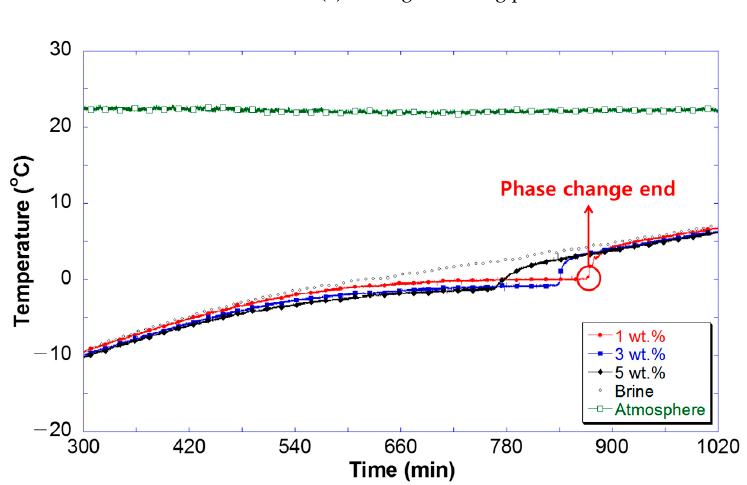
1 wt.%, 3 wt.% and 5 wt.% without SAP.